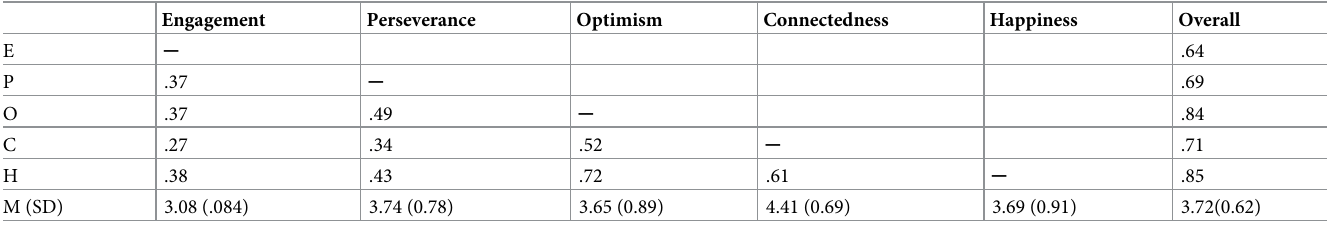
Table 2. Descriptive statistics for the EPOCH subscales and intercorrelations between the EPOCH subscales and overall scale ( N = 846). Engagement Perseverance Optimism Connectedness Happiness